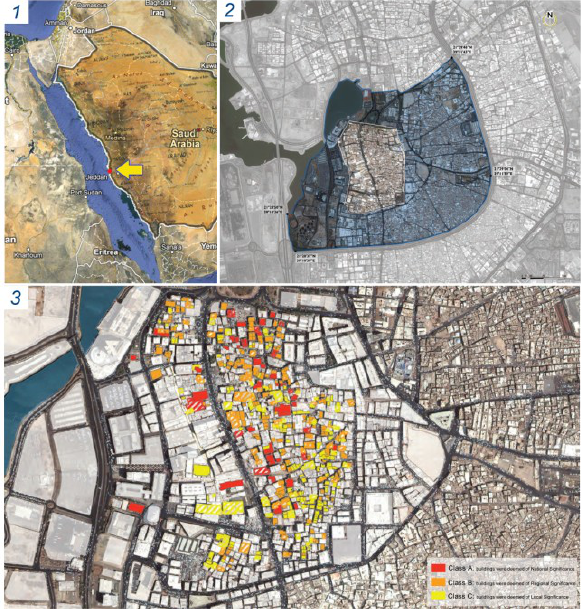
Figure 2. 1) The location of Jeddah city in Saudi Arabia,